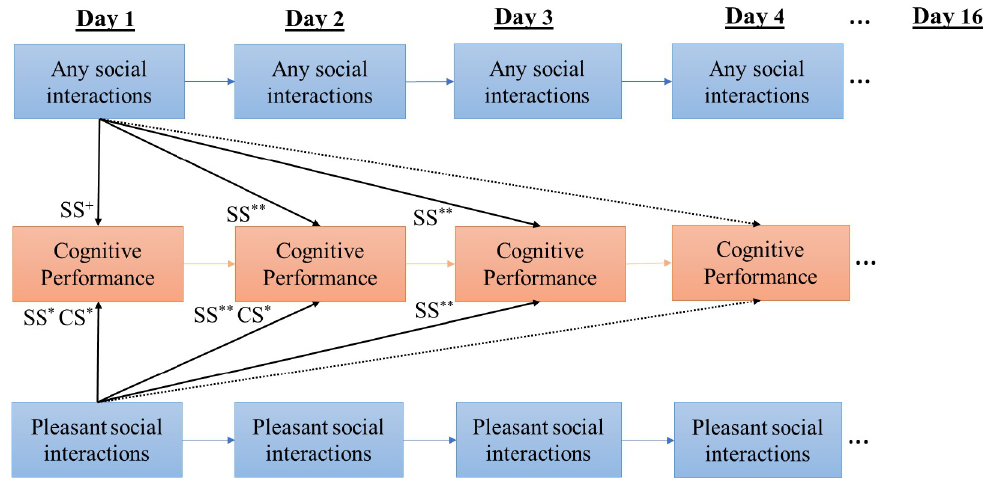
Fig 2. Summary of the within-person effects of daily social interactions on cognitive performance within the same day and across days (SS = Symbol Search; CS = Color Shape). Solid lines indicate significant effects and dashed lines indicate non-significant effects. + p < .10. � p < .05. �� p < .01).